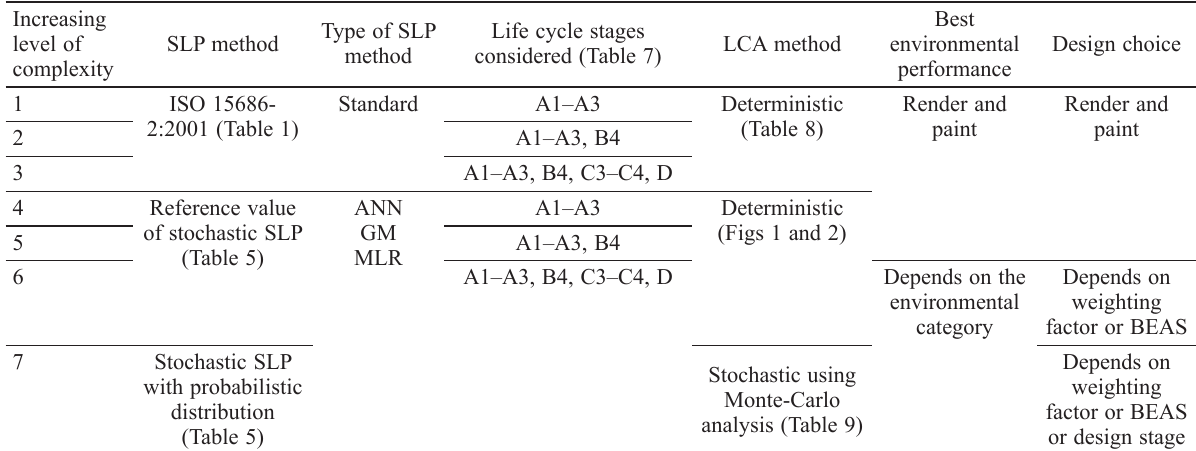
table 10. overview of the increasing level of complexity in the combined use of statistical models for SlP and lCA of building assemblies, the external cladding solution that offers the better environmental performance and the design choice increasing level of